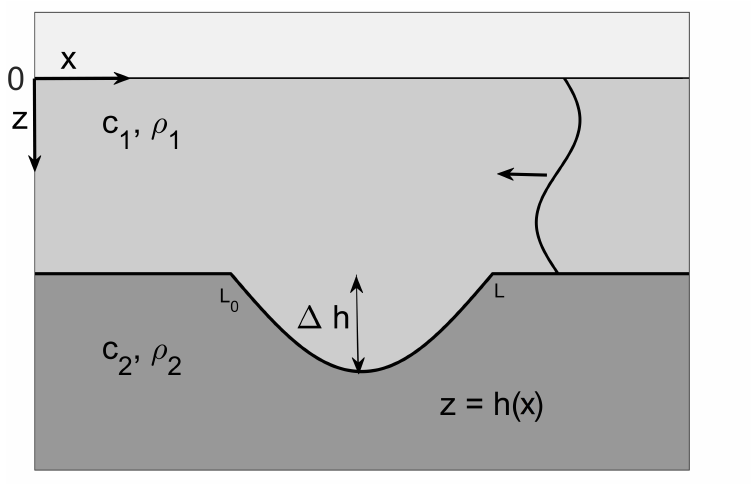
Figure 1. The scheme of a waveguide in a shallow sea with a bottom-relief